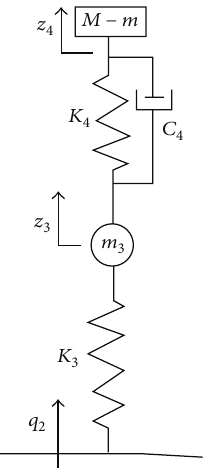
Figure 15: Vibration model of the rear